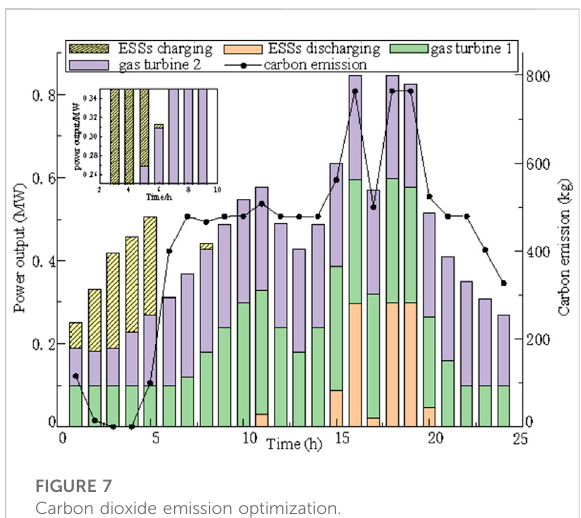
FIGURE 5 Cost curves in different cases.